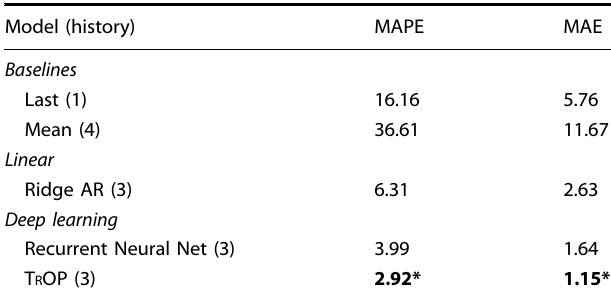
Table 1. Comparison of T R OP to alternative models with the inclusion of yearly topic data and using optimal yearly history length per model